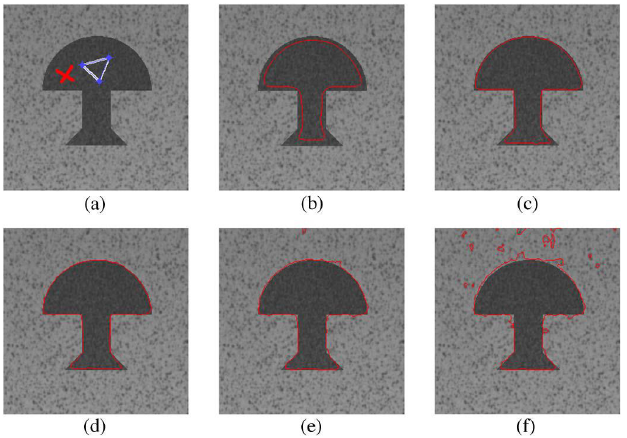
Figure 7. Impact of the parameter β on the accuracy of the segmentation result ( cf . [14]): ( a ) initial contour; ( b ) α = 2 and β = 1; ( c ) α = 2 and β = 2.5; ( d ) α = 2 and β = 3.5; ( e ) α = 2 and β = 4; ( f ) α = 2 and β =